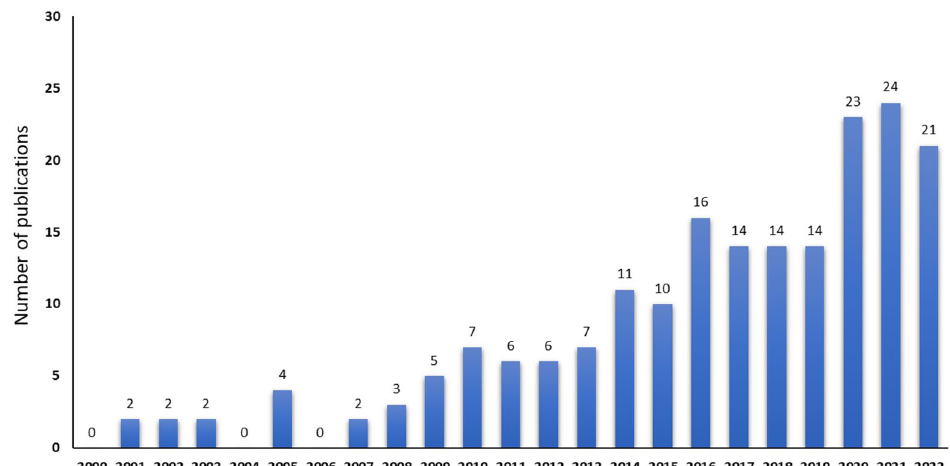
Figure 1. Schematic representation of the number of published studies from 2000 to 2022 based on isolation, identification, and cardioprotective activity of apigenin, quercetin, and silymarin/silibinin.